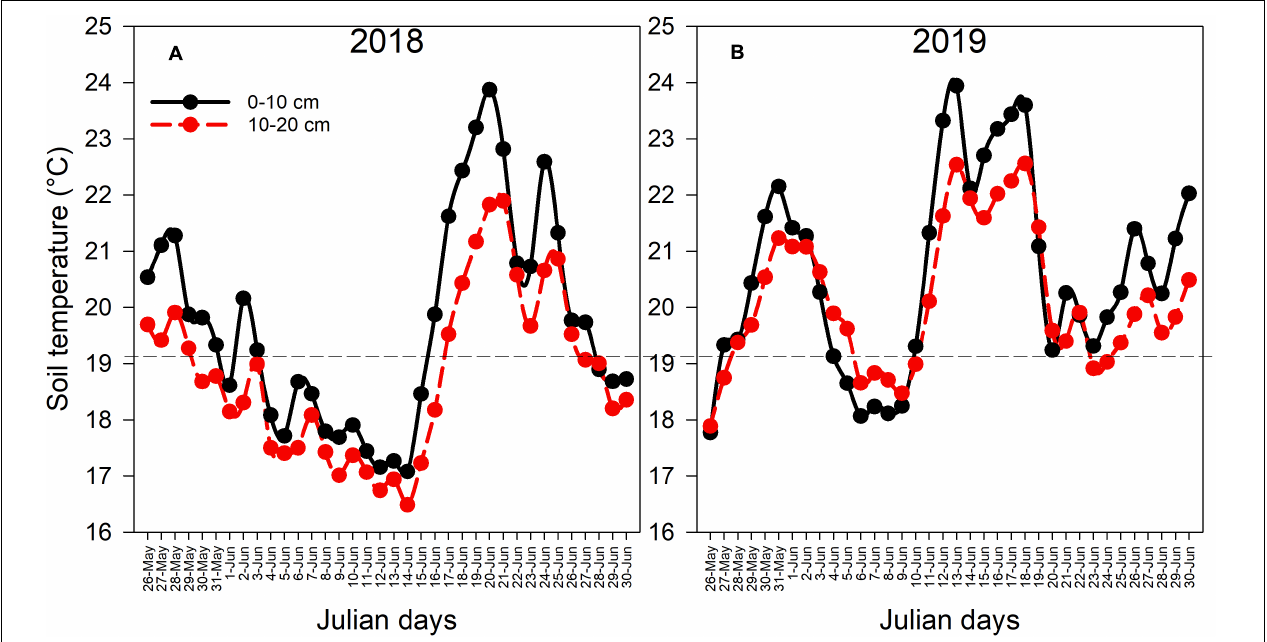
FIGURE 1 | Average soil temperature during the periods (A) May 26, 2018 and (B) May 26,